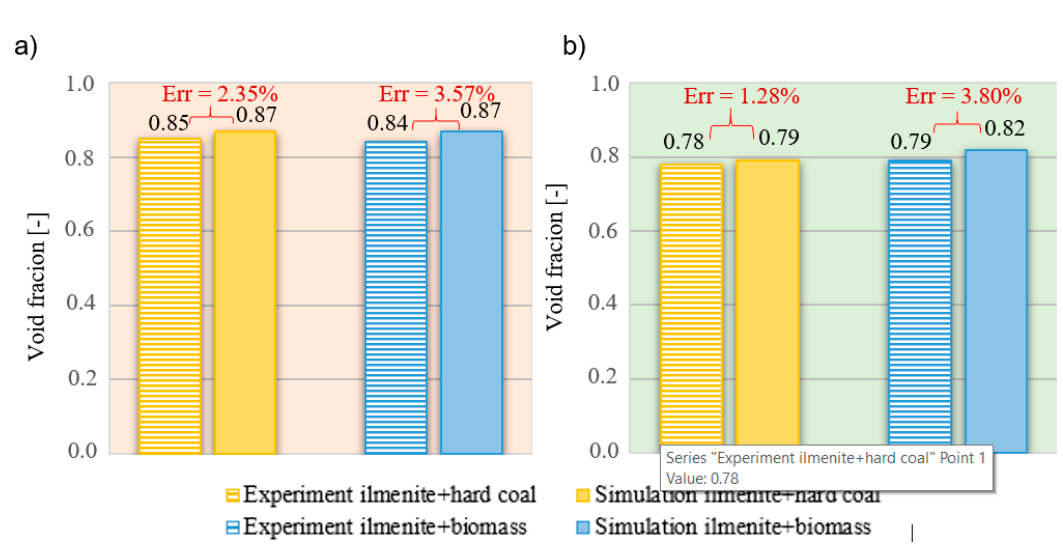
Figure 10. Experiment and simulation results for the dense region: ( a ) AR ( b ) FR. Energies 2020 , 13 , x FOR PEER REVIEW